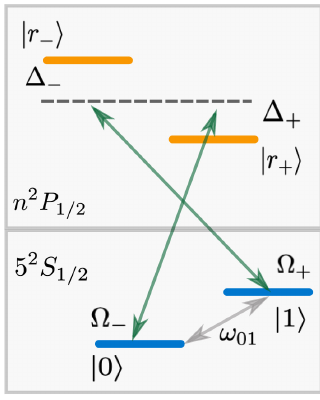
FIG. 3. The level schematics for the entanglement qubot. |¯ 0 (cid:3) =